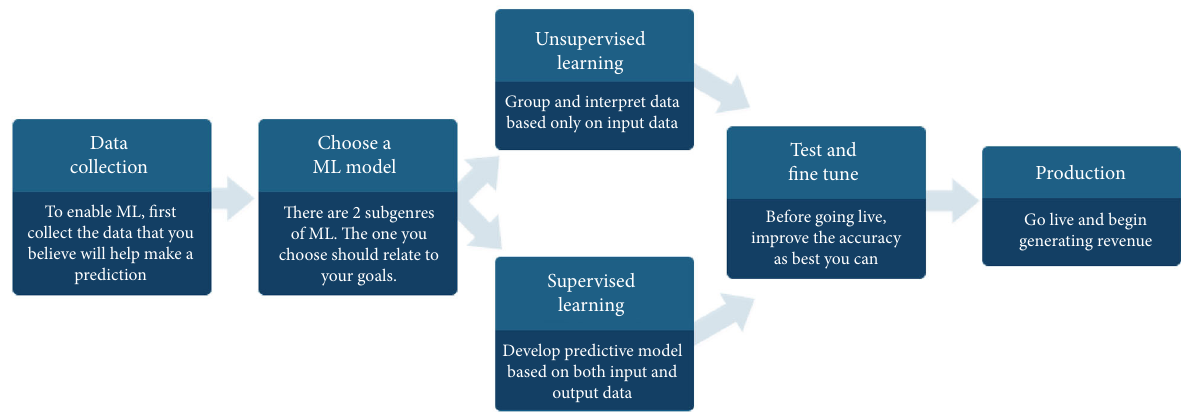
Figure 5: ML work fl